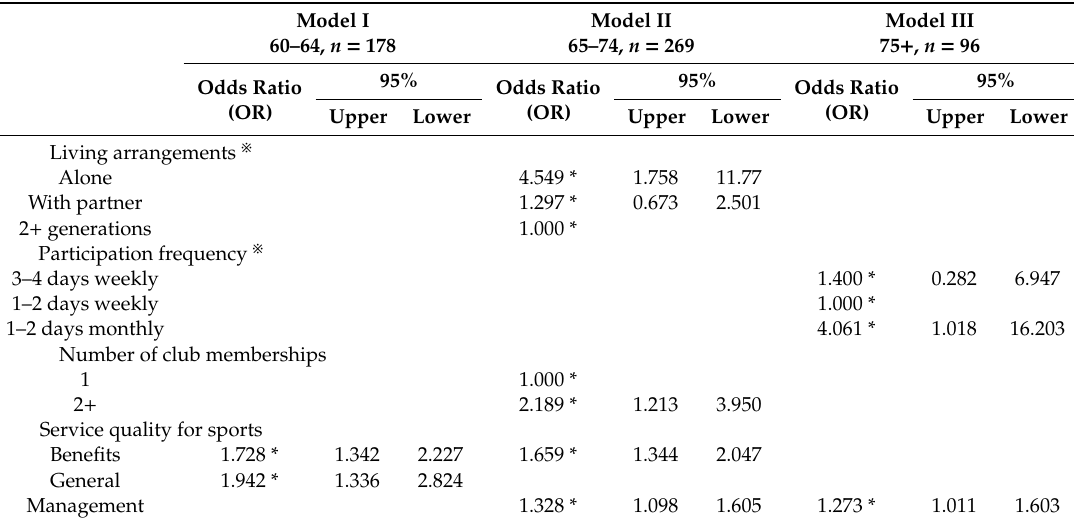
Table 3. Multiple logistic regression model for factors associated with healthy active aging, stratified by age